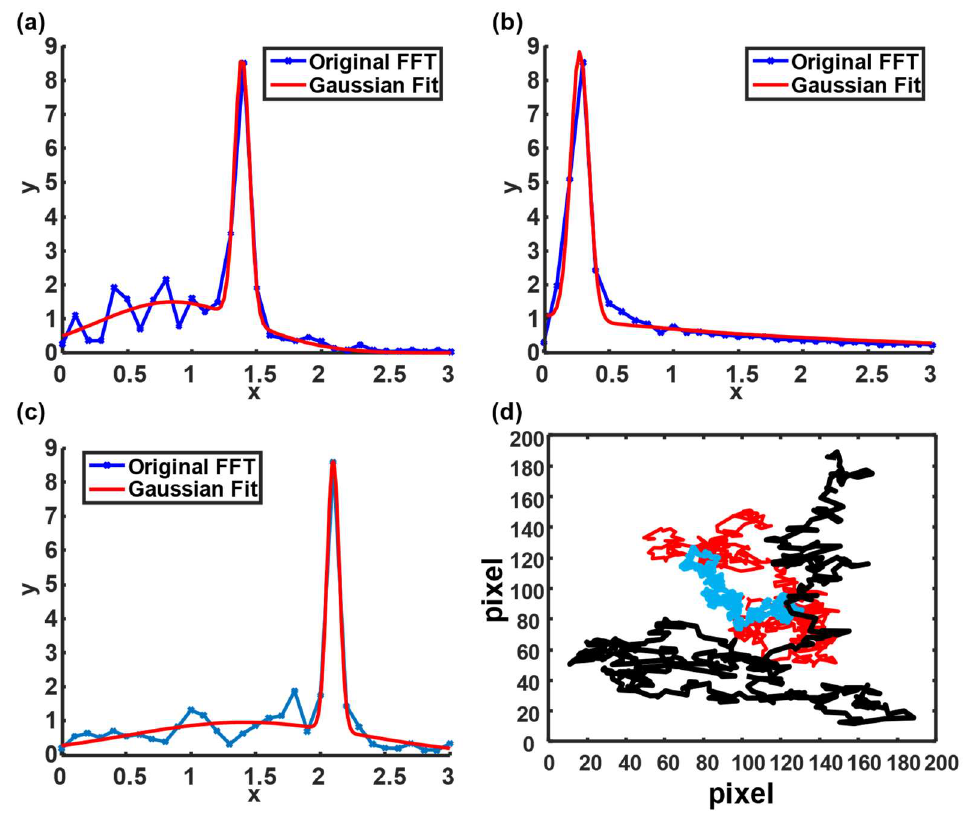
Figure 4. Blinking frequency and particle trajectory under different conditions. ( a – c ) Blinking fre- quency under the following conditions: 25 °C and 1 mPa·s, 25 °C and 5 mPa·s, and 40 °C and 1 mPa·s. ( d ) The particle trajectory of different conditions. Red, blue, and black lines denote the par- ticle trajectories simulated under the following conditions: 25 °C and 1 mPa·s, 25 °C and 5 mPa·s, and 40 °C and 1 mPa·s, respectively.